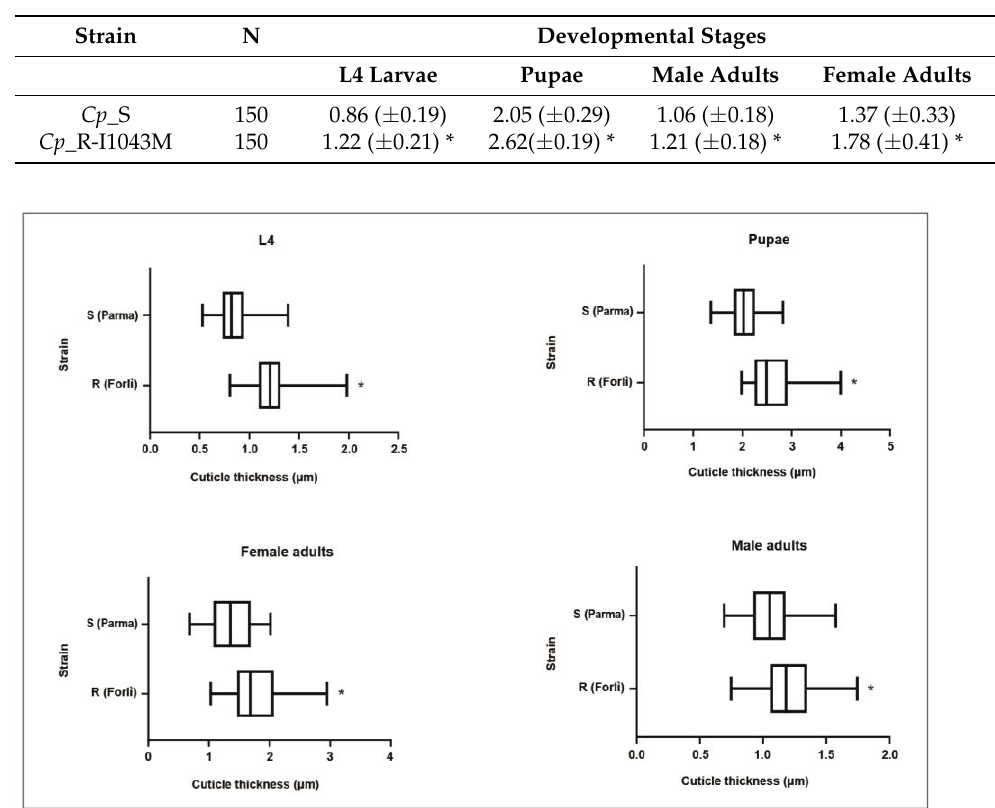
Figure 2. Analysis of cuticle thickness in Cx. pipiens. Cuticular thickness in susceptible and resistant mosquitoes at different life stages is shown. The boxes represent the 25% and 75% percentile and the black lines within the boxes indicate the medians; error bars correspond to the 10th and 90th percentiles. * p < 0.001 as determined by the Mann – Whitney test.